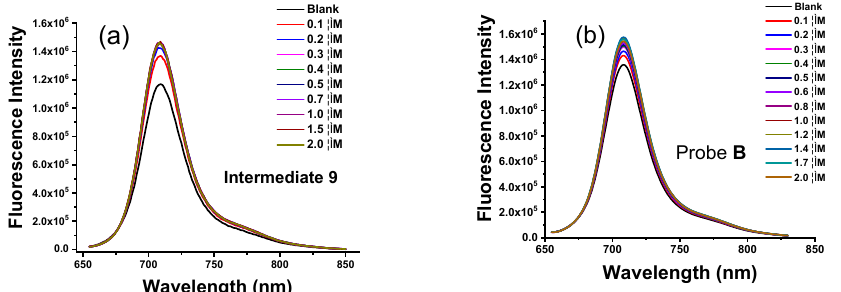
Figure 3. ( a ) Fluorescence spectra of intermediate 4 , and ( b ) probe A at 635 nm excitation upon gradual addition of Zn(II) from 0.1 µ M to 2.0 µ M to 10 mM HEPES bu ff er solutions (pH 7.0) containing 1.0 µ M probe A . ( c ) Intensity dependence on zinc ion concentration of 1.0 µ M intermediate 4 and ( d ) probe A upon gradual addition of Zn(II) from 0.1 µ M to 2.0 µ M to 10 mM HEPES bu ff er solutions (pH 7.0) containing 1.0 µ M probe A.